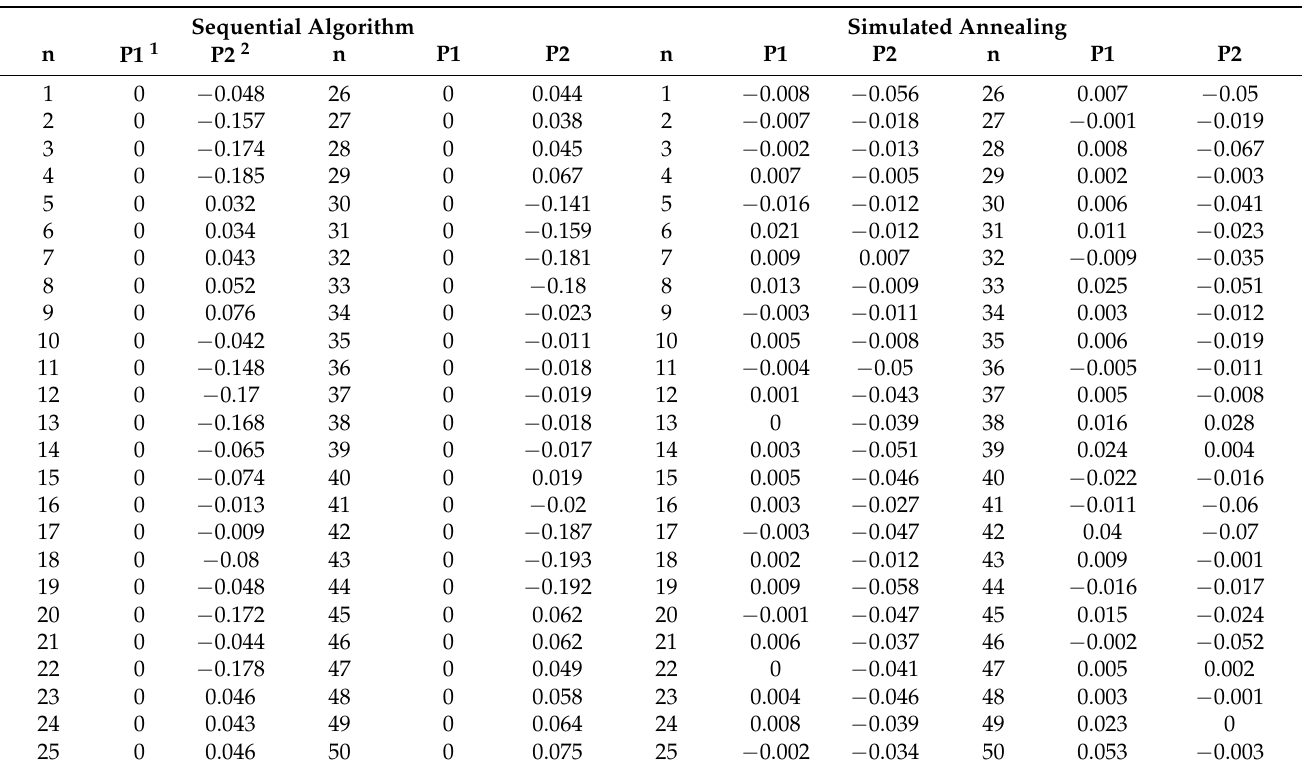
Table 2. Results of the